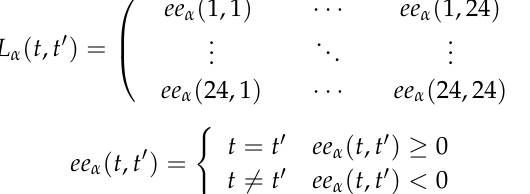
Figure 1. Structure of MCNMG.